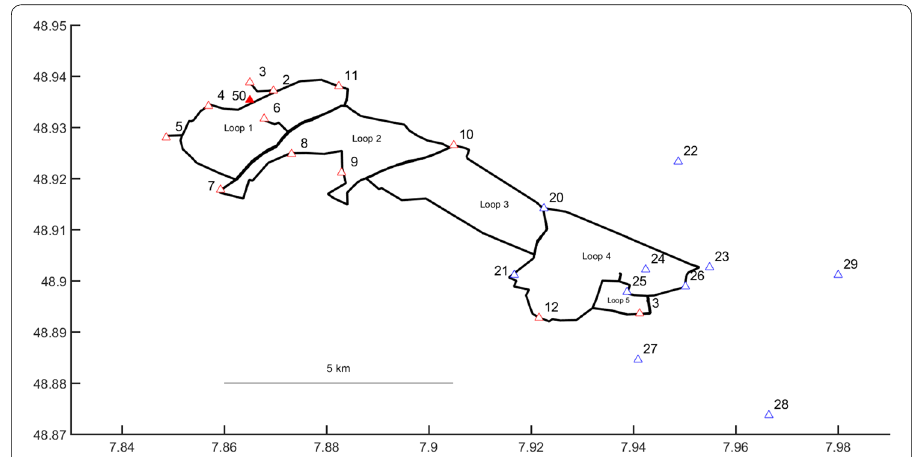
Fig. 3 The five loop map of the Soultz‑sous‑Forêts leveling network connecting gravity stations (red trian‑ gles). In addition, Rittershoffen gravity stations are represented with blue triangles; the elevation of stations which are not included in loops has been monitored by GNSS measurement. The leveling and gravity refer‑ ence is the station 50 (bold red triangle)